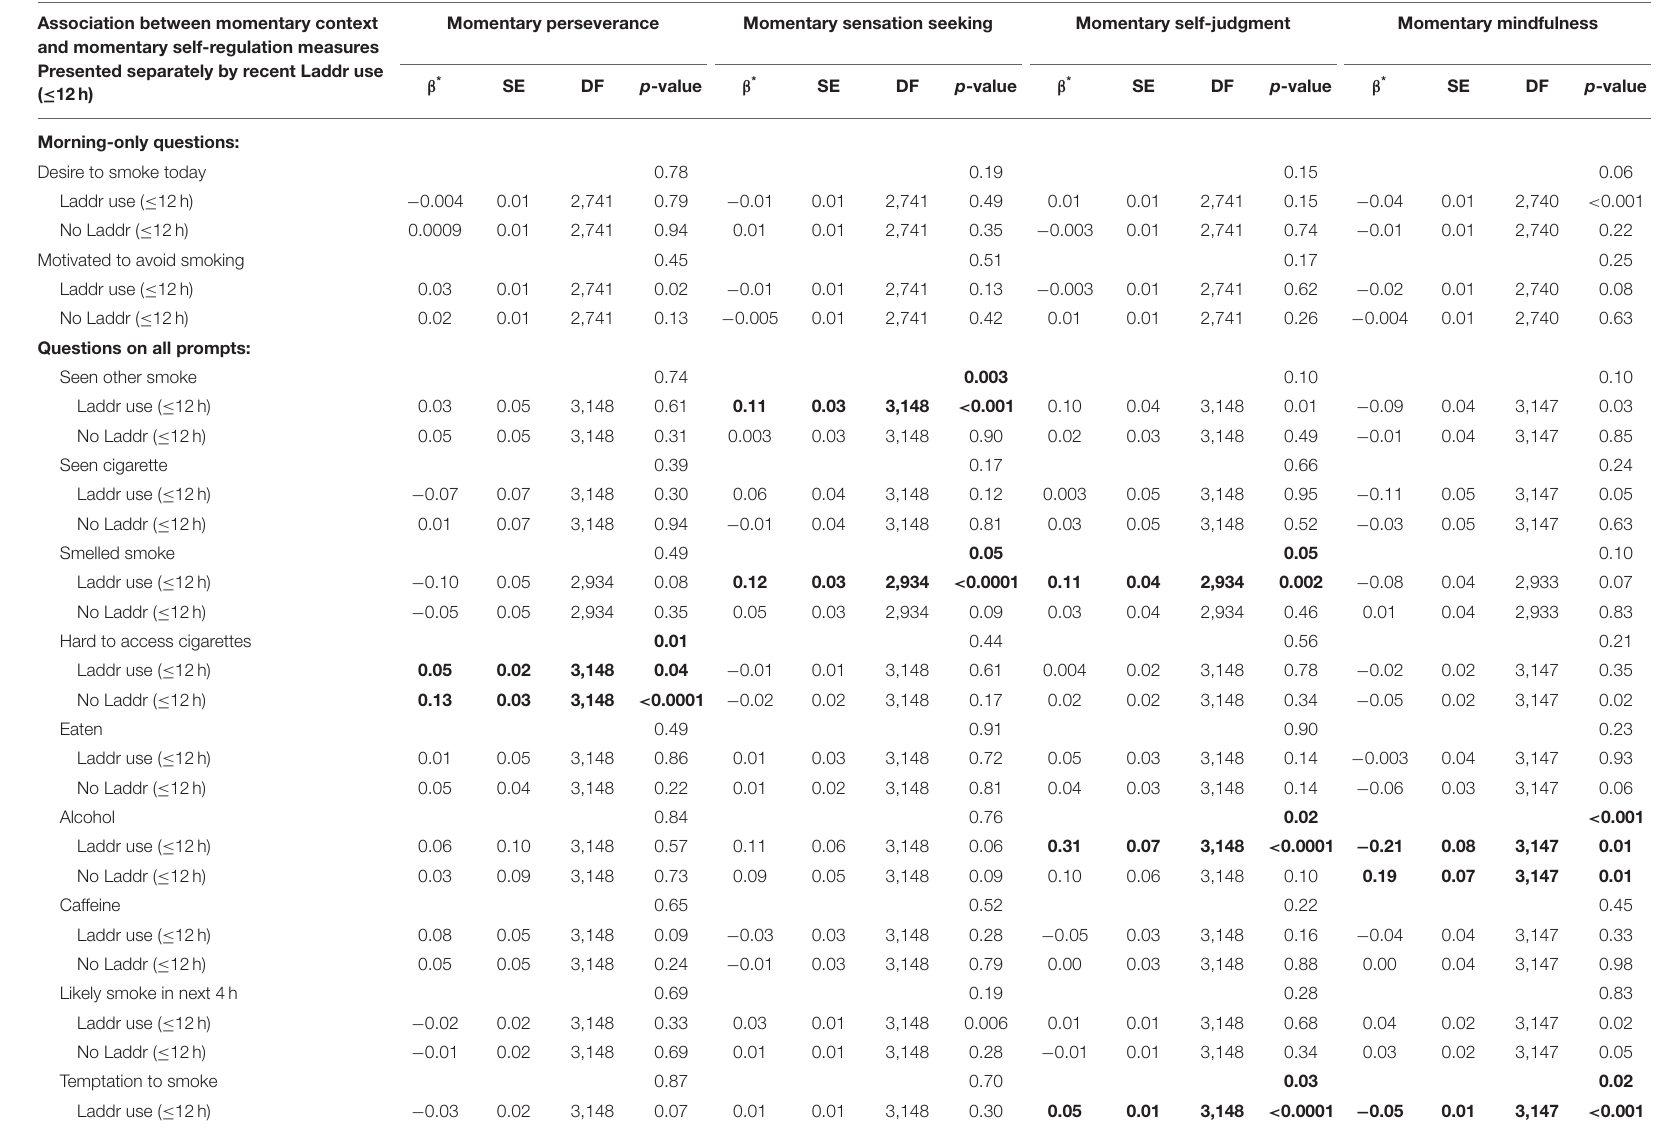
TABLE 6 | Momentary context measures, association with momentary self-regulation by recent Laddr use ( ≤ 12h) in the smoking sample. Association between momentary context and momentary self-regulation measures Presented separately by recent Laddr use ( ≤